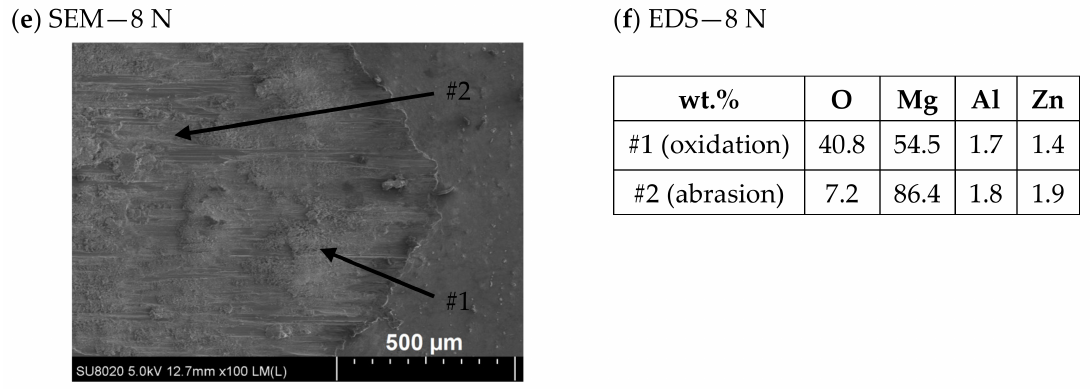
Figure 3. SEM and EDS analysis of AZ31 magnesium alloy in tribology: ( a ) SEM—2 N, ( b ) EDS—2 N, ( c ) SEM—5 N, ( d ) EDS—5 N, ( e ) SEM—8 N, ( f ) EDS—8 N.